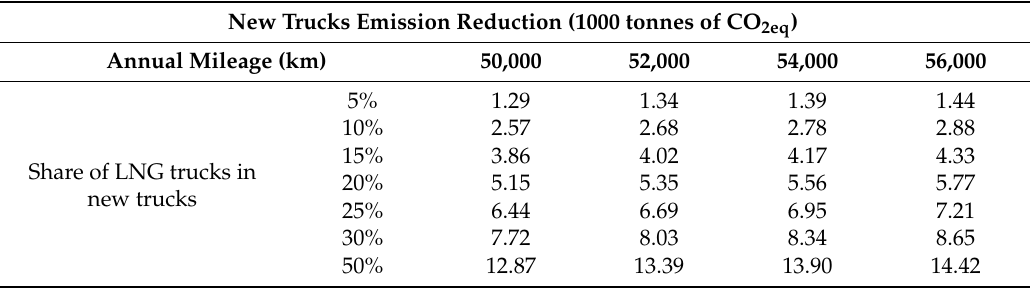
Table 8. GHG emission reduction for different LNG truck shares on Republic of Croatia level.